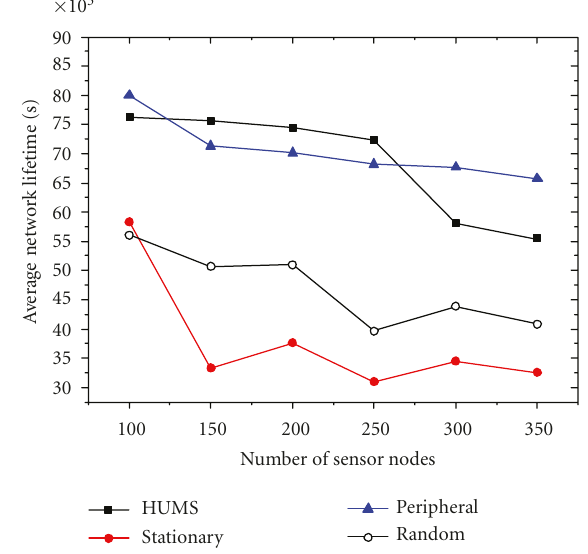
Figure 6: Network lifetimes varied with di ff erent initial energy for each sensor node.